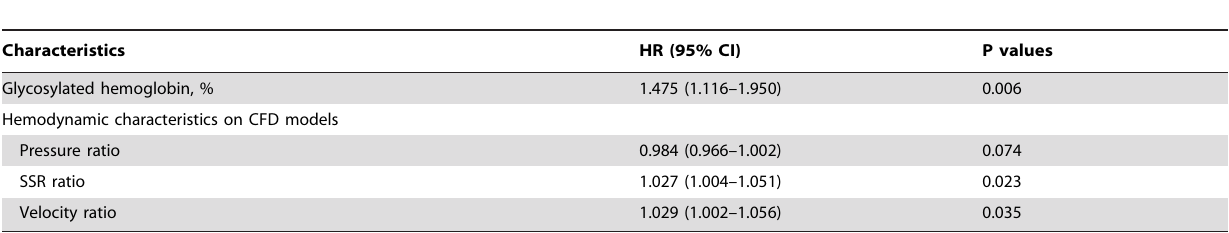
Table 2. Results of univariate Cox regression for predictors of recurrent ischemic stroke in the territory of the qualifying artery.